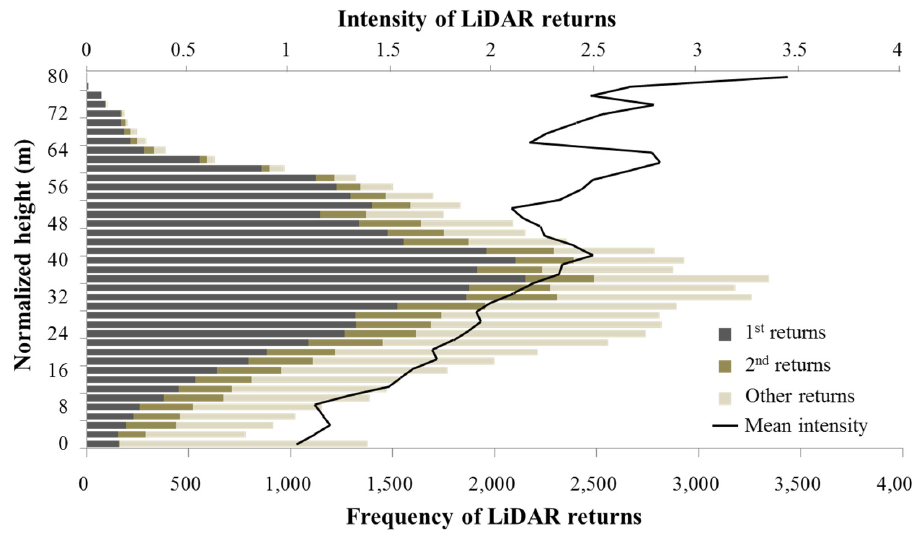
Figure 2. Distribution of normalized height values and mean intensities of 1st, 2nd and the other remaining returns of the LiDAR